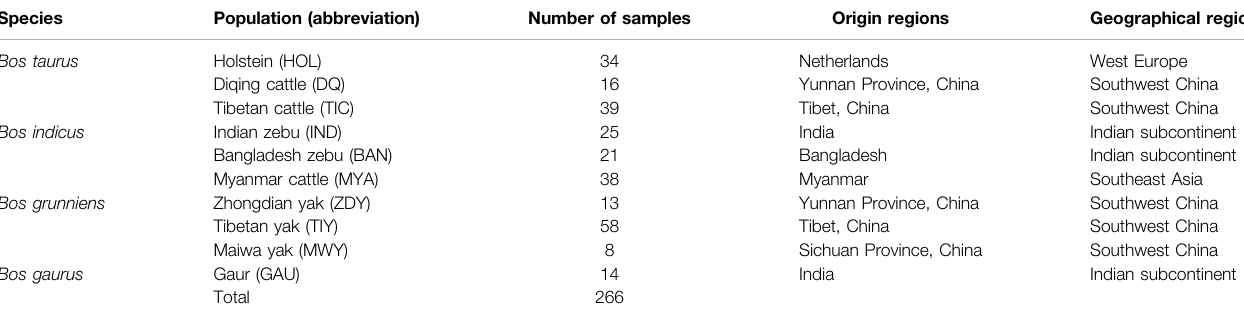
TABLE 1 | Sample information of 266 samples from 10 bovine